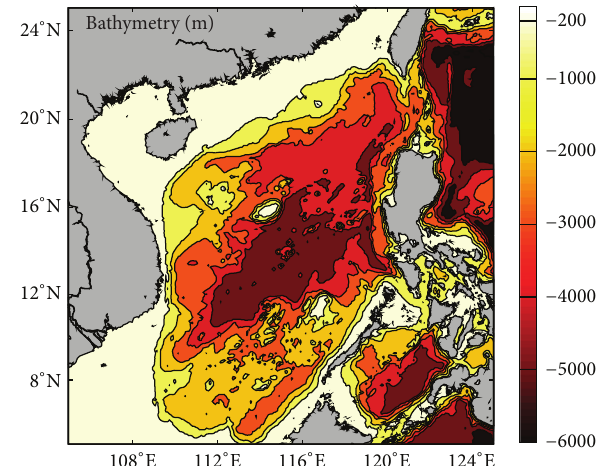
Figure 1: Topographical map of the South China